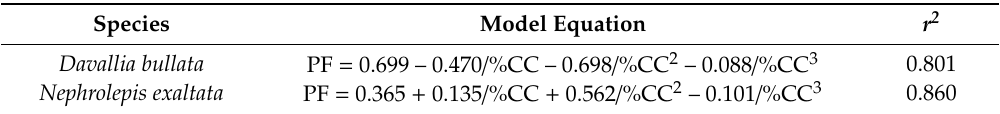
Table 2. Best fit models for predicting daily ET A values for D. bullata and N. exaltata plants produced from liners to marketable